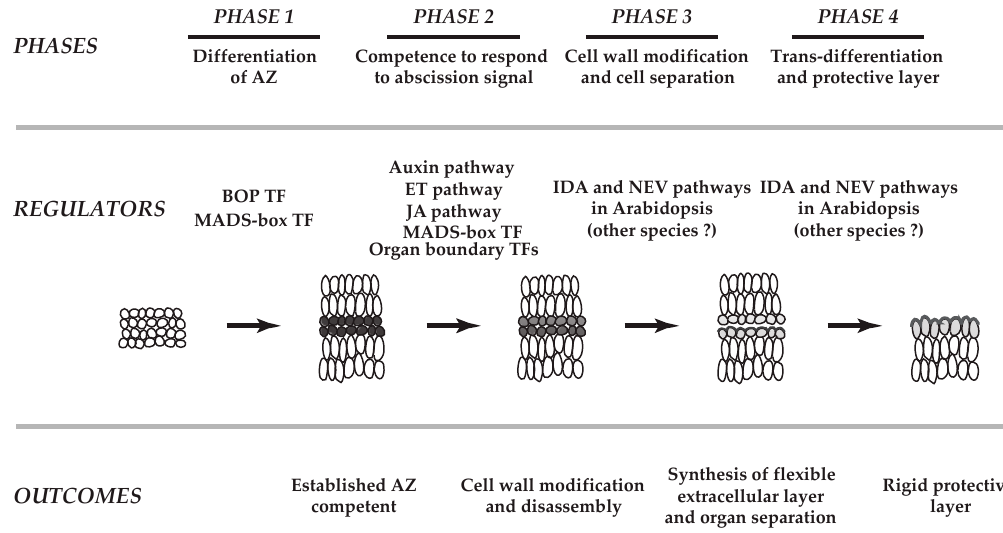
Figure 1. A schematic model of abscission in plants. The working model for abscission consists of four basic phases. First, di ff erentiation of abscission zone (AZ); second, acquisition of the competence of the AZ to respond to abscission signals (e.g., decline in auxin); third, cell wall modifications and cell separation; and fourth, trans-di ff erentiation of the AZ and formation of a protective layer. Based on recent transcriptome analyses (Kim et al., 2015, Kim et al., 2016), roles of transcription factors (TFs) that define the boundary layer cells in the AZs (Organ boundary TFs, Phase 2) and genes linked to the synthesis of flexible extracellular matrix (outcome of Phase 3) are implemented on the previously proposed four phases of separation processes (modified from Patterson, 2001 and Kim, 2014). In Phase 1, both tomato (Xu et al., 2016) and Arabidopsis (McKim et al., 2008) BOP TFs, and a tomato MADS-box TF of JOINTLESS (Mao et al., 2000) are known to be critical in establishment of AZ. MADS-box TFs (e.g., AGL15, AGL18, AGL24) a ff ect timing of abscission in Arabidopsis (Phase 2). In addition, a membrane tra ffi c regulator (NEVERSHED, NEV) and a small signaling peptide (INFLORESCENCE DEFICIENT IN ABSCISSION, IDA) are associated with cell wall disassembly and modifications in Phase 3 and Phase 4 of Arabidopsis, but their specific roles in other species have not been determined.